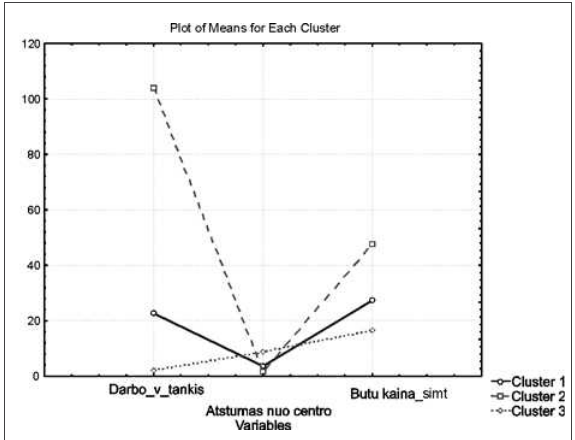
Fig 7. Diagram of variable means for each cluster